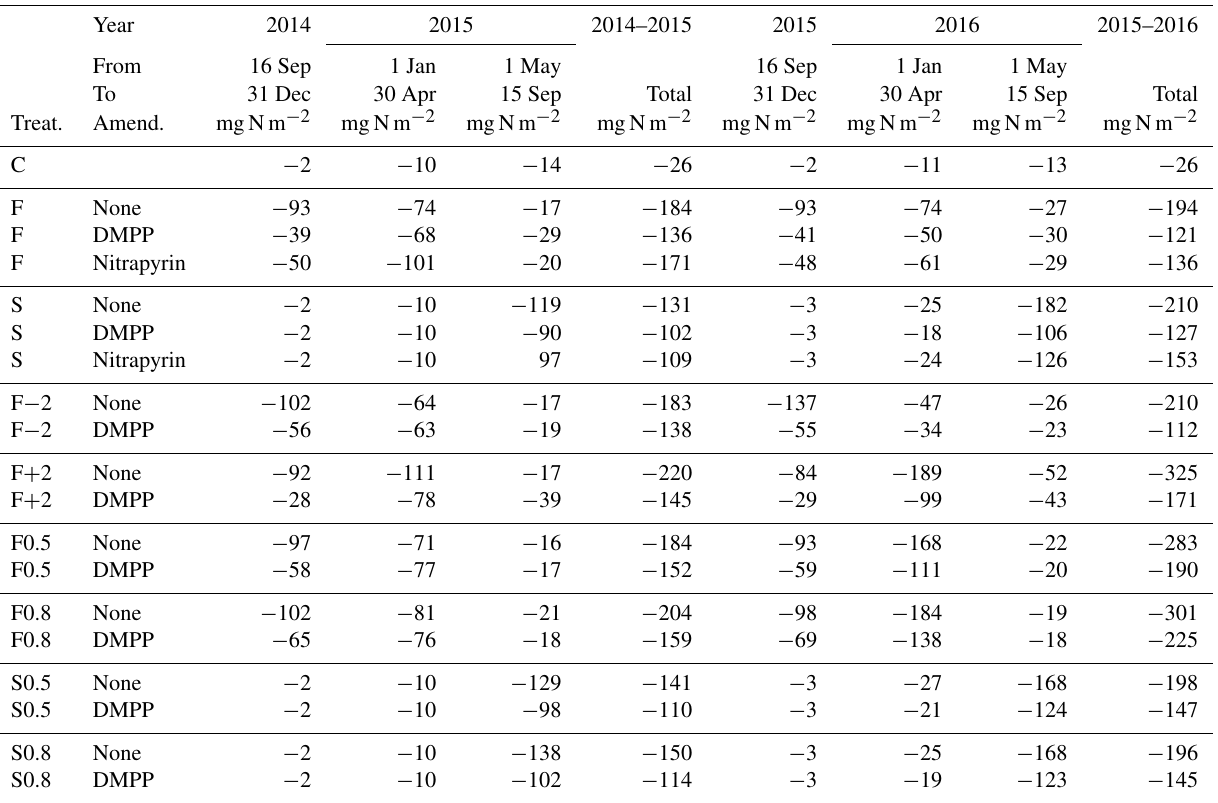
Table 6. Seasonal and annual N 2 O emissions modelled during autumn–winter, winter–spring and spring–summer in 2014–2015 and 2014– 2016 without slurry (C) or with slurry applied in fall (F) or spring (S) without NI or with R I for DMPP on dates in the field study (Table 3), in fall on dates 2 weeks before (F − 2) or after (F + 2) those in the field study, and with soil mixing during slurry application (M) increased to 0.5 and 0.8 from 0.2 in the field study. Negative values denote